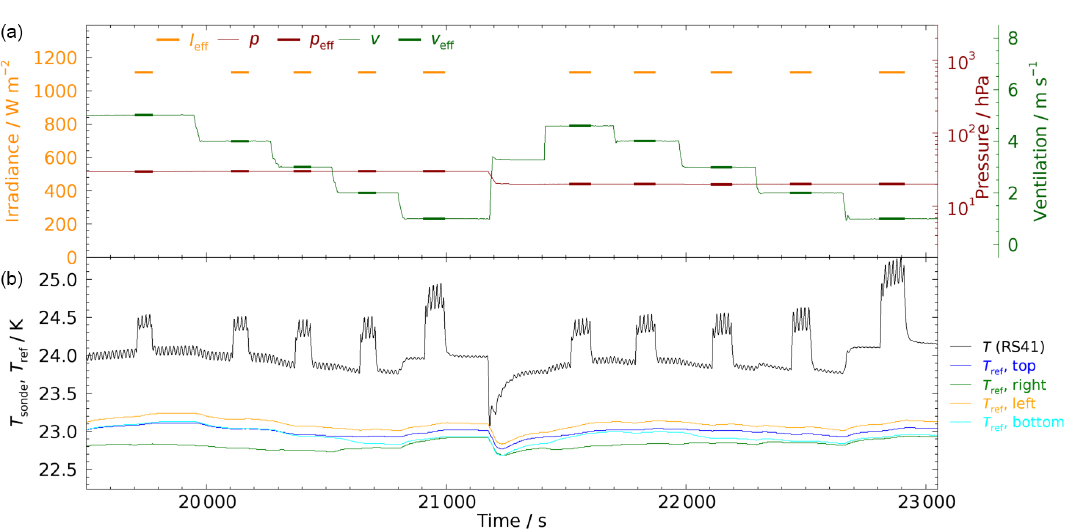
Figure 10. Section of raw data for a setup with an incidence of α = 40 ◦ . (a) Continuous data for pressure and ventilation speed (solid lines); bars indicate values averaged over periods of exposure of the sensor boom for irradiance, pressure, and ventilation. (b) Temperature records of the RS41 radiosonde (black curve) and of the four reference thermistors (coloured curves, with a − 1K